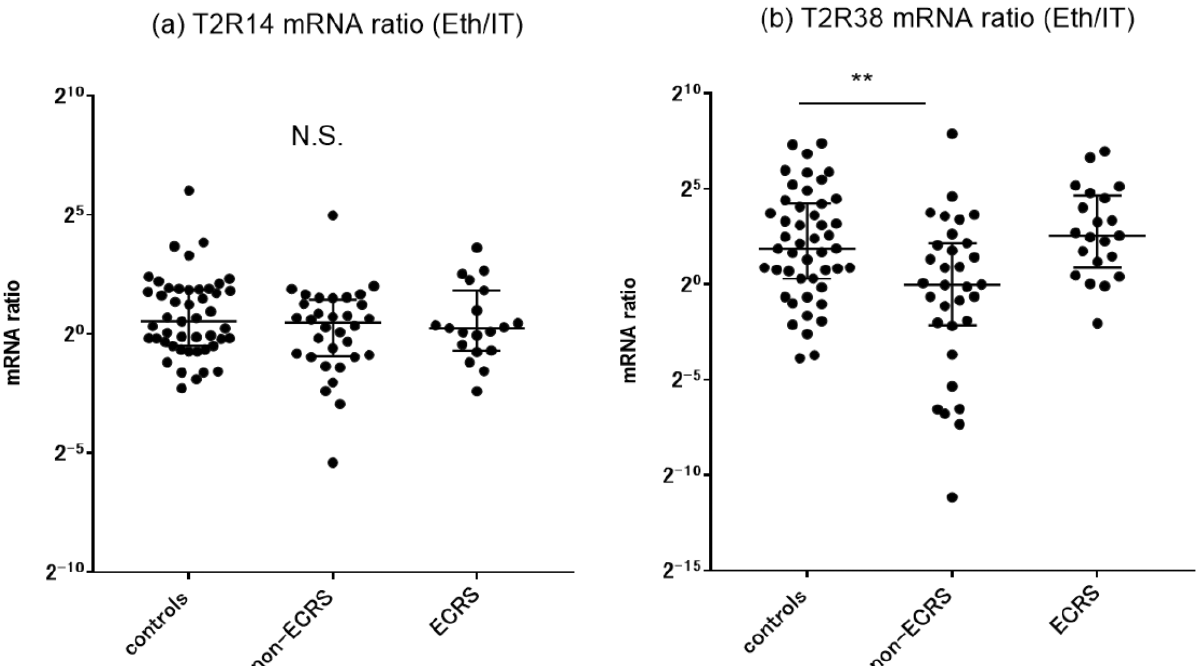
Figure 3. Comparison of the mRNA expression ratios of ethmoid sinus to inferior turbinate mucosa (Eth/IT ratio) for each subject in the control, non-ECRS, and ECRS groups. ( a ) T2R14 and ( b ) T2R38. ** p < 0.01. Center lines, median values; error bars, interquartile ranges; N.S., not significant.